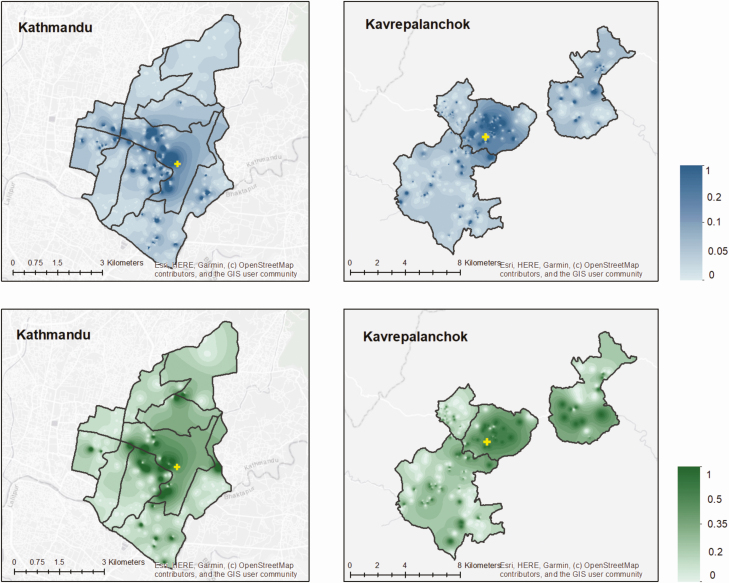
Proportion of individuals with fever in past 8 weeks (top) or hospitalized in past month (bottom) who sought care at the study hospitals in Kathmandu and Kavrepalanchok. Yellow crosses denote the location of study surveillance hospitals.